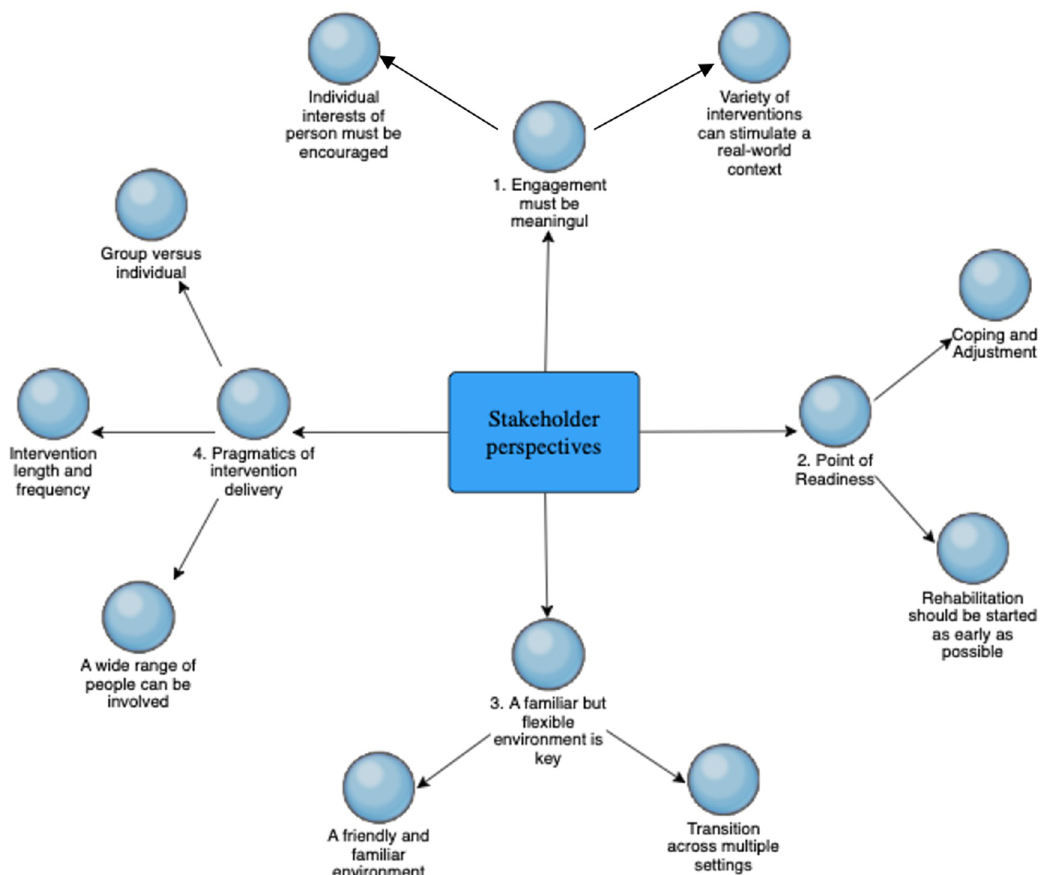
Fig 1. Concept map of key themes and